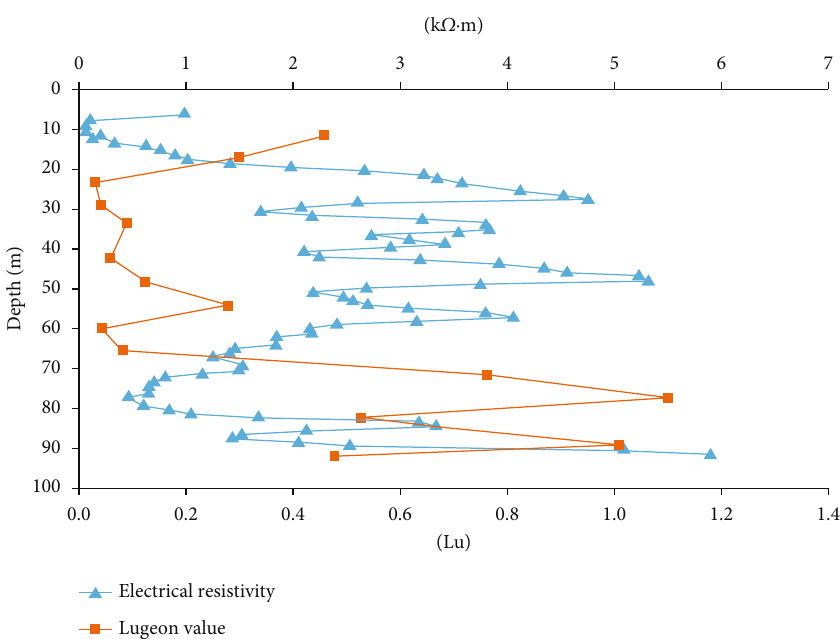
Figure 6: Borehole 1 comparison curves of electrical resistivity and Lugeon value